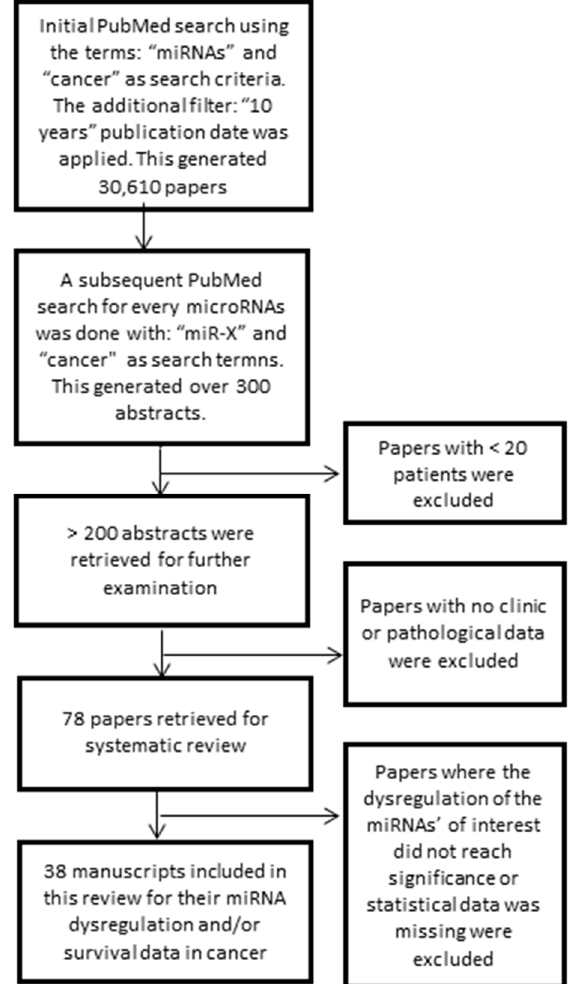
Figure 2. Diagram showing the overall pathway followed to obtain reported significant data for miR98, miR-152, miR-326 and miR-4289 deregulation in human cancers.